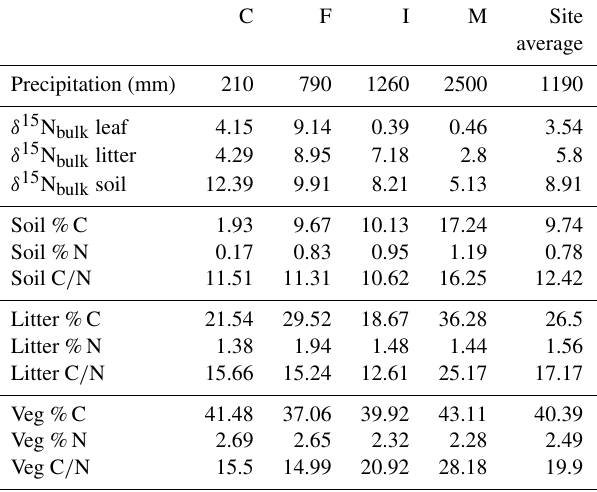
Table 1. Site averages, for all bulk samples. Percent C and N and C / N are